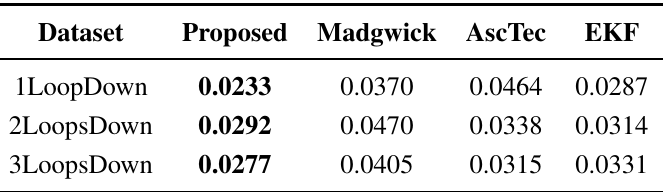
Figure 6. 2D top view ( left ) and 3D side view ( right ) of the trajectory traveled by the quadrotor during the “1LoopDown” experiment. Table 1. RMS roll angle error [radians].